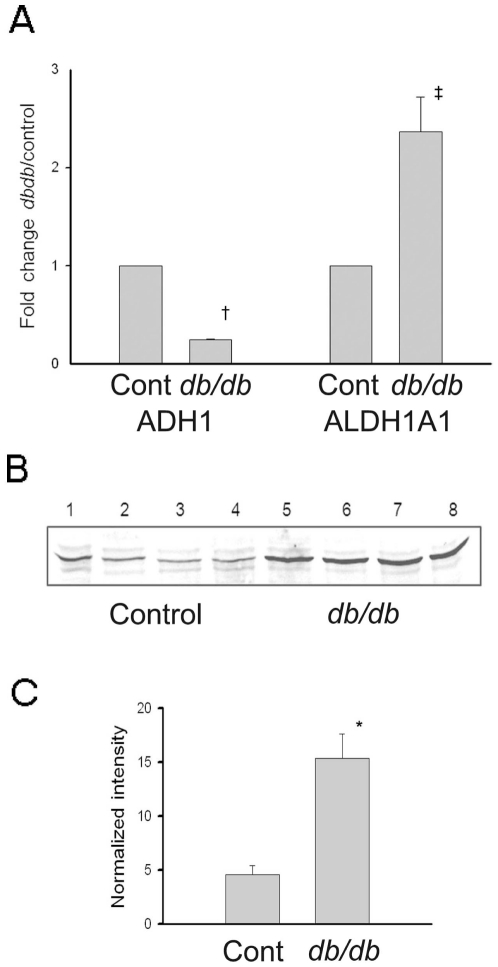
Real time-PCR and western blot of RALDH1 (ALDH1A1) and real time-PCR of ADH.Real time-PCR was analyzed using the ΔCT method and results are scaled to the mean control values ±SE (n = 7). Western blots were performed in duplicate and normalized to β-actin (n = 7) and results are represented as mean±SE. A. RNA was extracted from 50 mg of kidney cortical tissue and cDNA synthesis performed according to the manufacturer's instructions. Relative quantification of RALDH1 and ADH mRNA was performed using a MyiQ Single-Color Real-Time PCR Detection System. Control (n = 4) and diabetic (n = 7) results are normalized to the expression level of cyclophilin within each animal, and then plotted as fold change compared to the average control value. B. RALDH1 Western blots. Total tissue extracts were prepared from renal cortex of 3-month diabetic and age-matched control mouse kidneys. An equal amount of protein (50 µg/lane) was used for all animals, and representative control (lanes 1–4) and db/db (lanes 5–8) Western blots are shown. C. Densitometric quantification of RALDH1 for 7 control and 7 diabetic mice. Results are expressed as a mean and SD of the control and diabetic band intensities after normalization to β actin in each lane. Student's t-test: *p<0.005; †p<0.001; ‡p<0.01.